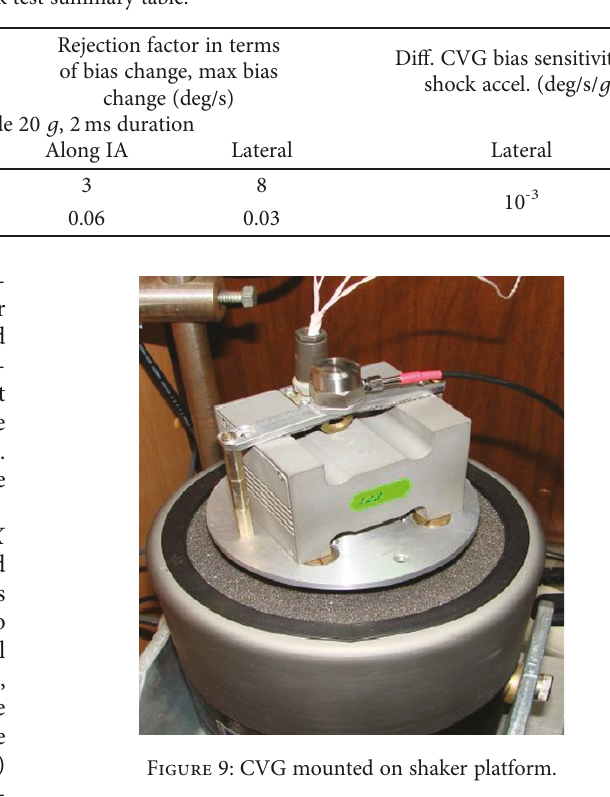
Table 1: Shock test summary table.